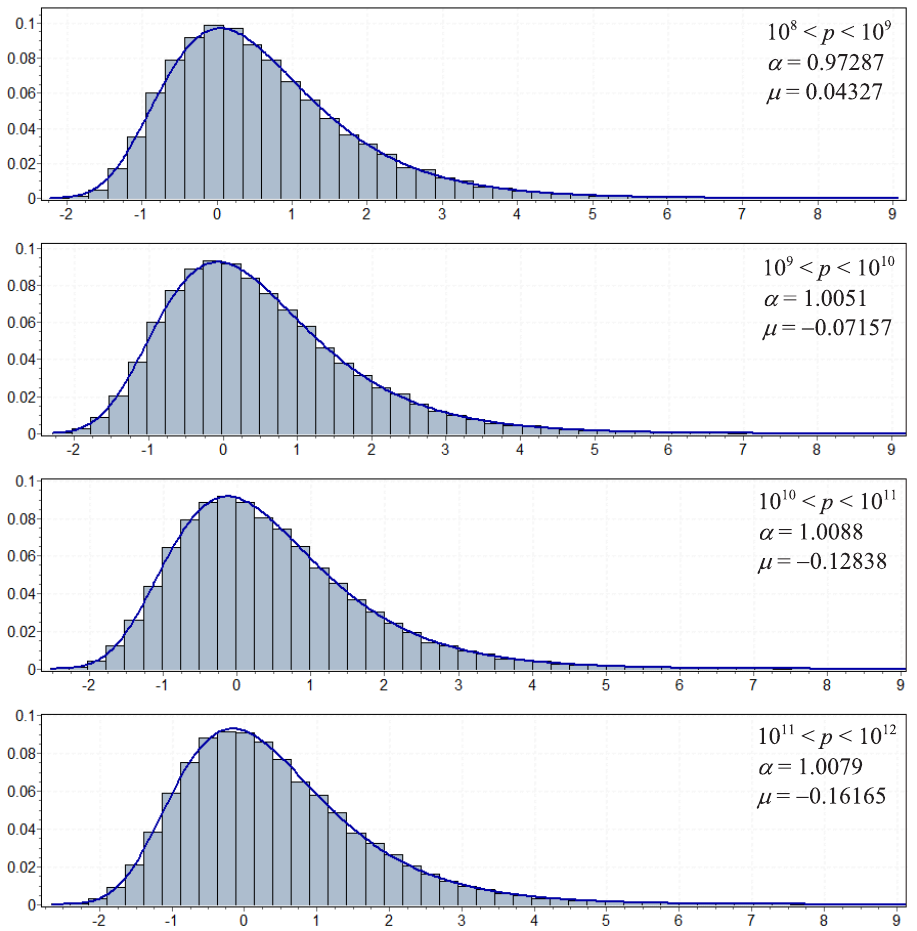
Figure 5. Histograms of h -values (48) for maximal gaps G c between lesser twin primes p = r + nq ∈ P c for q = 16001 and H -allowed residue classes r ∈ [ 1,16000 ] , r (cid:54) = 15999. Curves are best-fit Gumbel distributions (pdfs) with scale α and mode µ